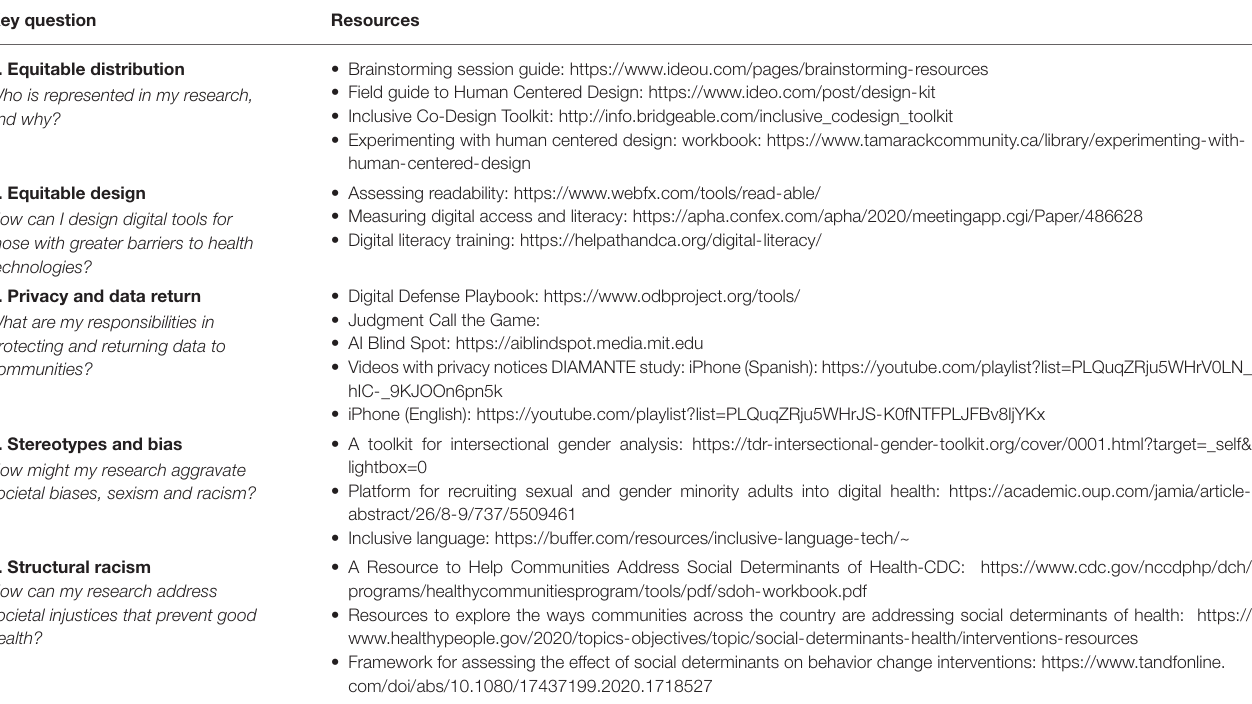
TABLE 3 | Additional resources to explore the questions outlined by the guide in